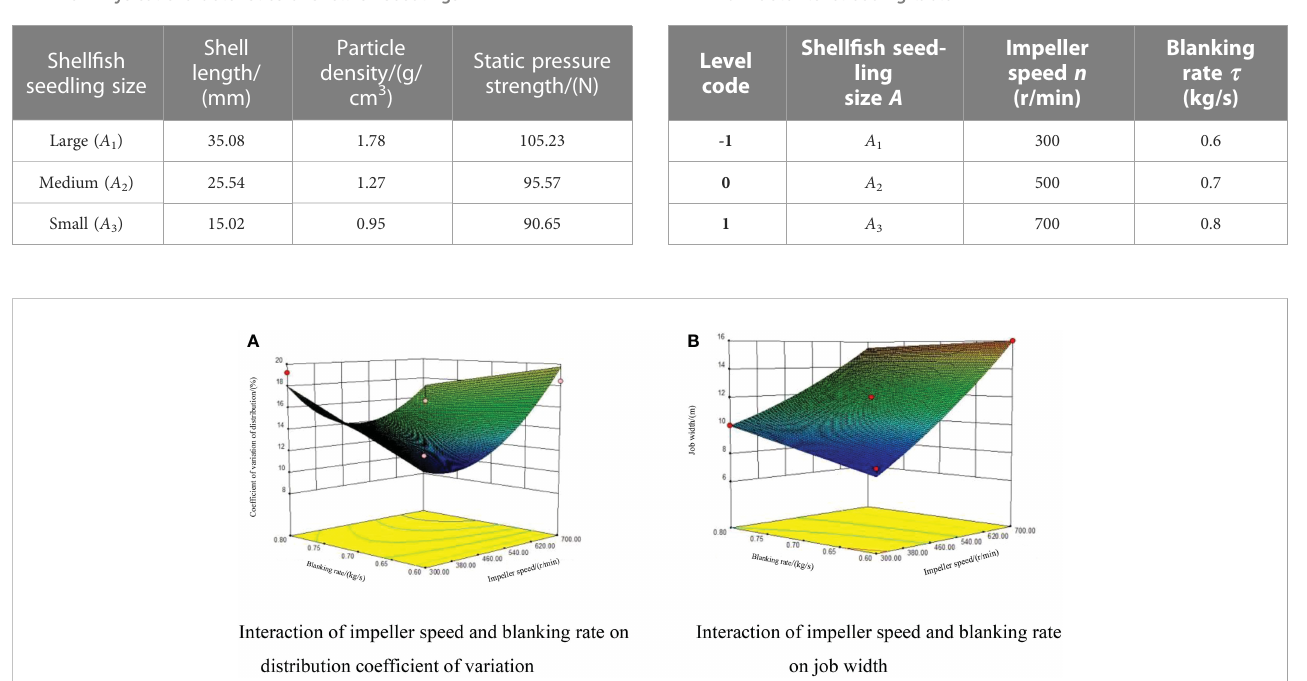
TABLE 5 Physical characteristics of shell fi sh seedlings.